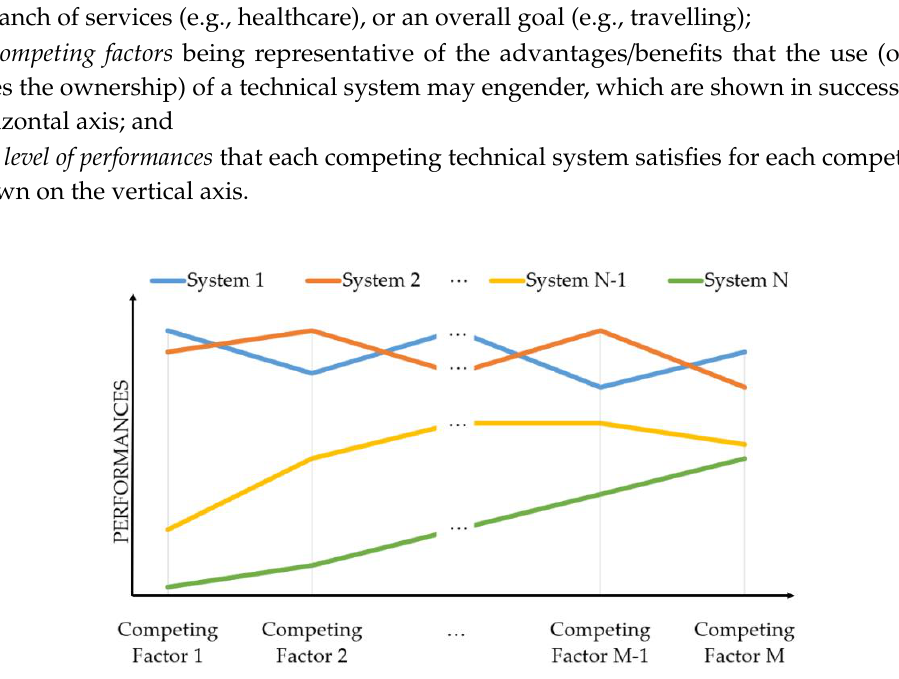
Figure 1. Illustrative example of value curves.